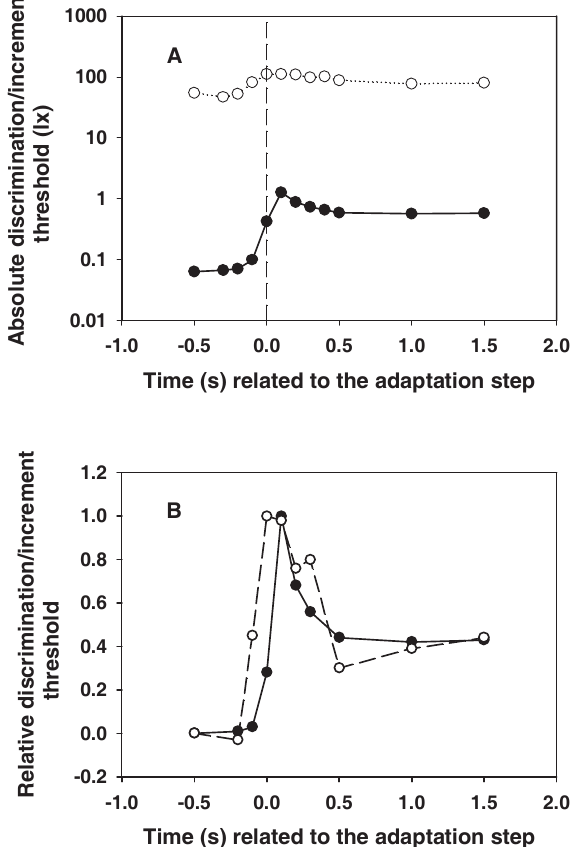
Figure 5. ( A ) Courses of subjective (points) and electroretinographic (circles) thresholds in the same diagram. Because of the large range to be displayed, the ordinate was graduated logarithmically; ( B ) Courses of subjective (points) and electroretinographic (circles) thresholds. They were made comparable by subtracting the initial threshold at − 0.5 s and dividing by the maximum value. In both courses, the values at − 0.1 s are already significantly different from the basic value of the threshold. Vision 2018 , 2 , 10